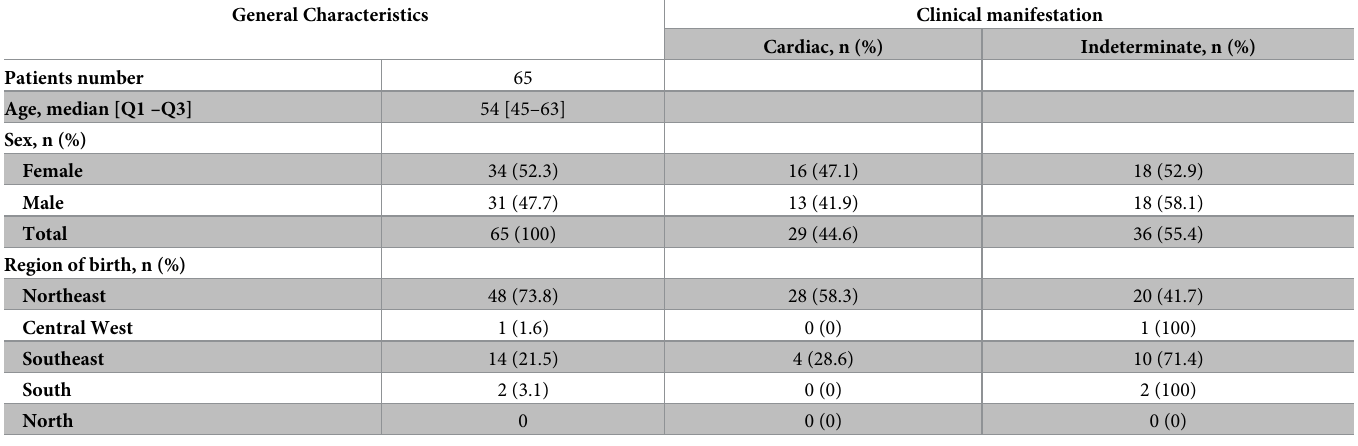
Table 1. General characteristics of patients included in the